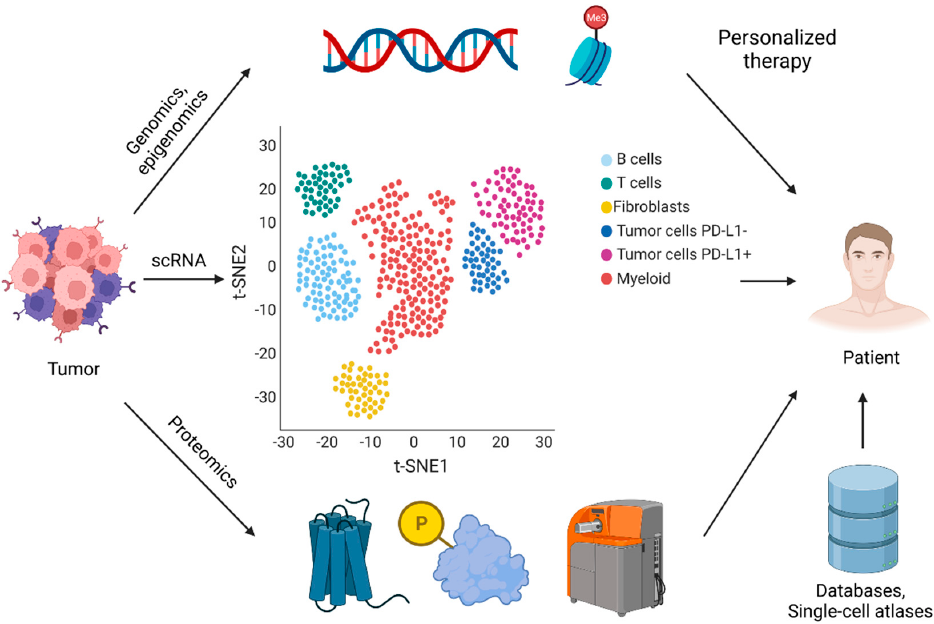
Figure 1. An illustration of using single-cell technologies and databases for personalized cancer